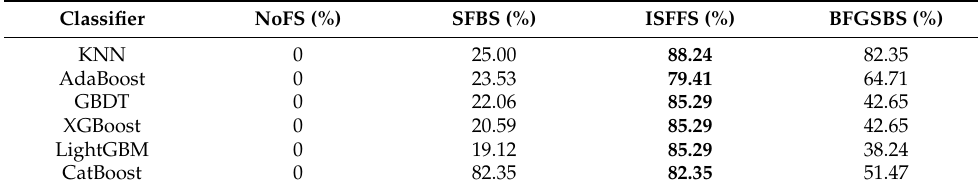
Table 11. Influence of different strategies on